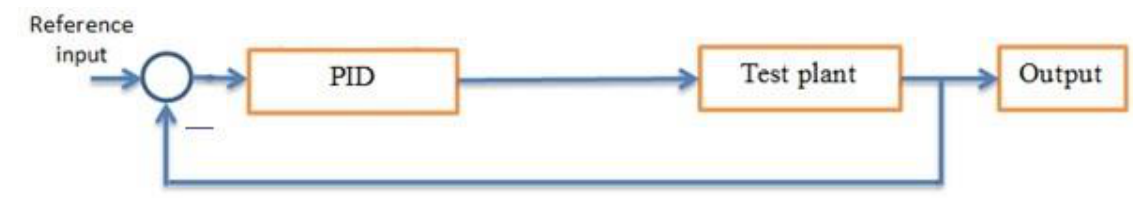
Fig. 2. Classical method to control the test